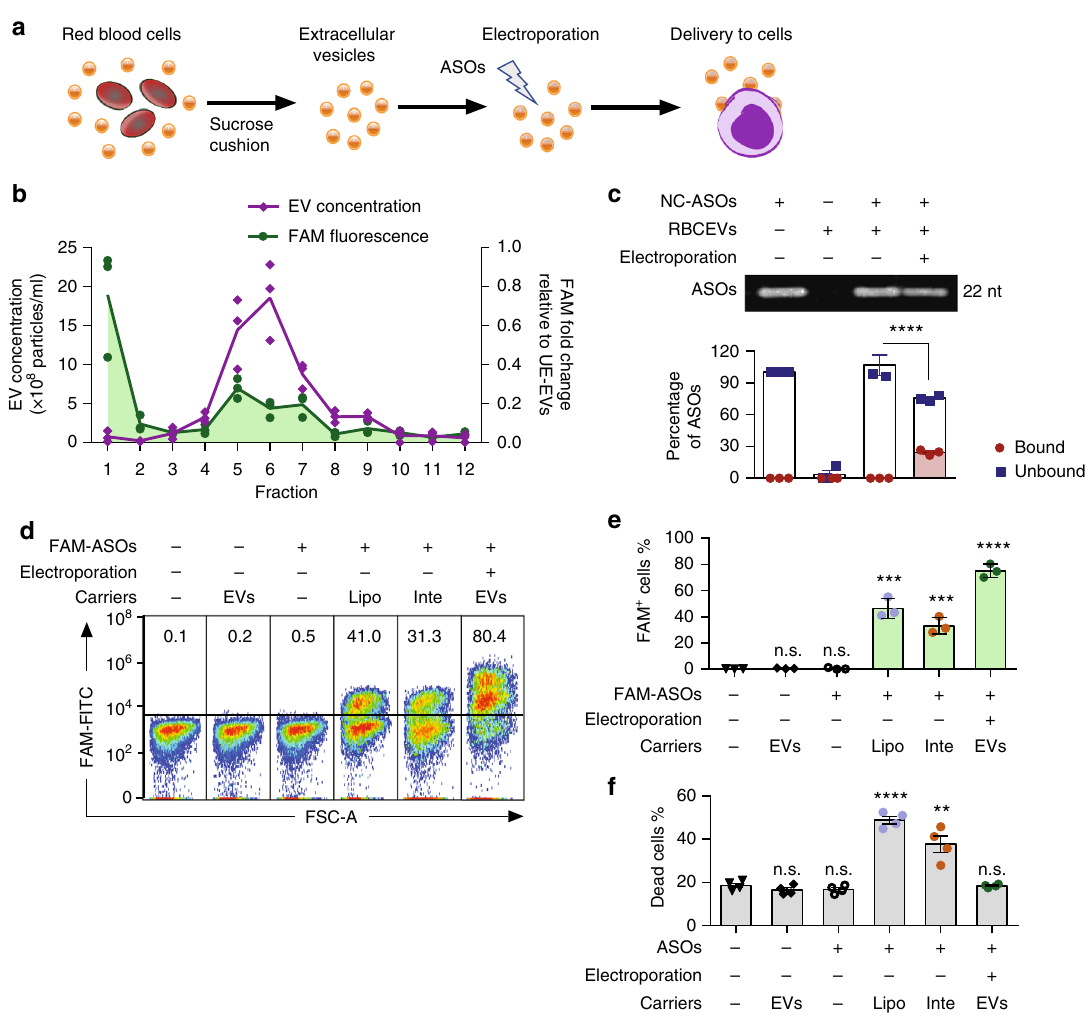
Fig. 2 Electroporation of RBCEVs with ASOs and delivery to leukemia cells. a Experimental scheme of ASOs delivery by RBCEVs. b Average concentration of EVs (200× dilution) and average fold change in FAM fl uorescent intensity relative to unelectroporated EVs (UE-EVs) of 12 fractions in a sucrose gradient separation of RBCEVs electroporated with a FAM-labeled scrambled negative control ASOs (FAM-NC-ASOs), determined using a Nanosight analyzer and Synergy fl uorescent microplate reader, respectively, n = 3 repeats. c Separation of unbound NC-ASOs (unlabeled) from 8.25 × 10 11 unelectroporated or electroporated RBCEVs compared to the untreated NC-ASOs (200 pmol) in 10% native gel, visualized using SYBR Gold staining (top) and the average percentage of NC-ASOs unbound or bound to electroporated RBCEVs (bottom), n = 3 independent replicates. d FACS analysis of FAM fl uorescence vs. forward scatter area (FSC-A) in MOLM13 cells transfected with 400 pmol FAM-NC-ASO using LipofectamineTM 3000 (Lipo), INTERFERin ® (Inte) or 12.4 × 10 11 RBCEVs. Percentages of FAM-positive cells are indicated above the gate. e Average percentages of FAM + cells among viable MOLM13 cells transfected or treated with RBCEVs containing FAM ASOs as in d , n = 3 repeats. f Percentages of dead cells determined by propidium iodide staining among MOLM13 cells transfected or treated with RBCEVs containing unlabeled NC-ASOs, n = 4 repeats. All graphs present mean ± SEM. Student ’ s one-tail t -test results are shown as n.s. non-signi fi cant; ** P < 0.01; *** P < 0.001 and **** P < 0.0001 relative to the unelectroporated control ( c )